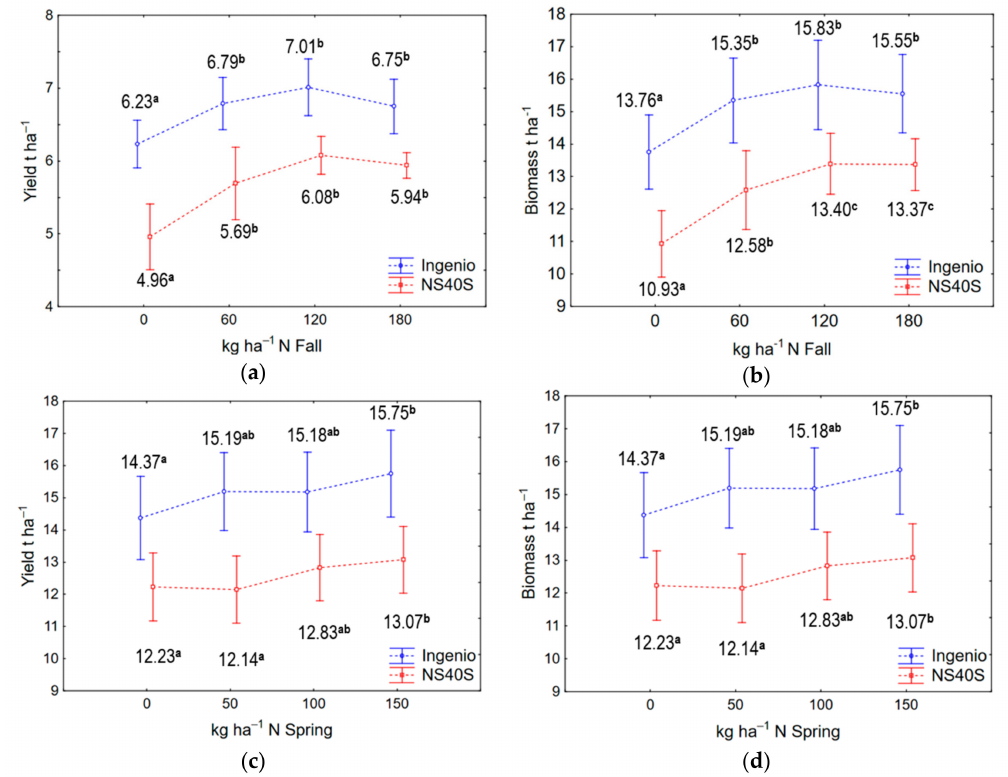
Figure 11. Effects of fall N fertilizer application ( a , b ) and spring N fertilizer application ( c , d ) on grain yield and biomass of Ingenio, and NS40S wheat varieties for 2018–2020 growing seasons. The letters on the graph represent different classes obtained by ANOVA with p = 0.05 level of